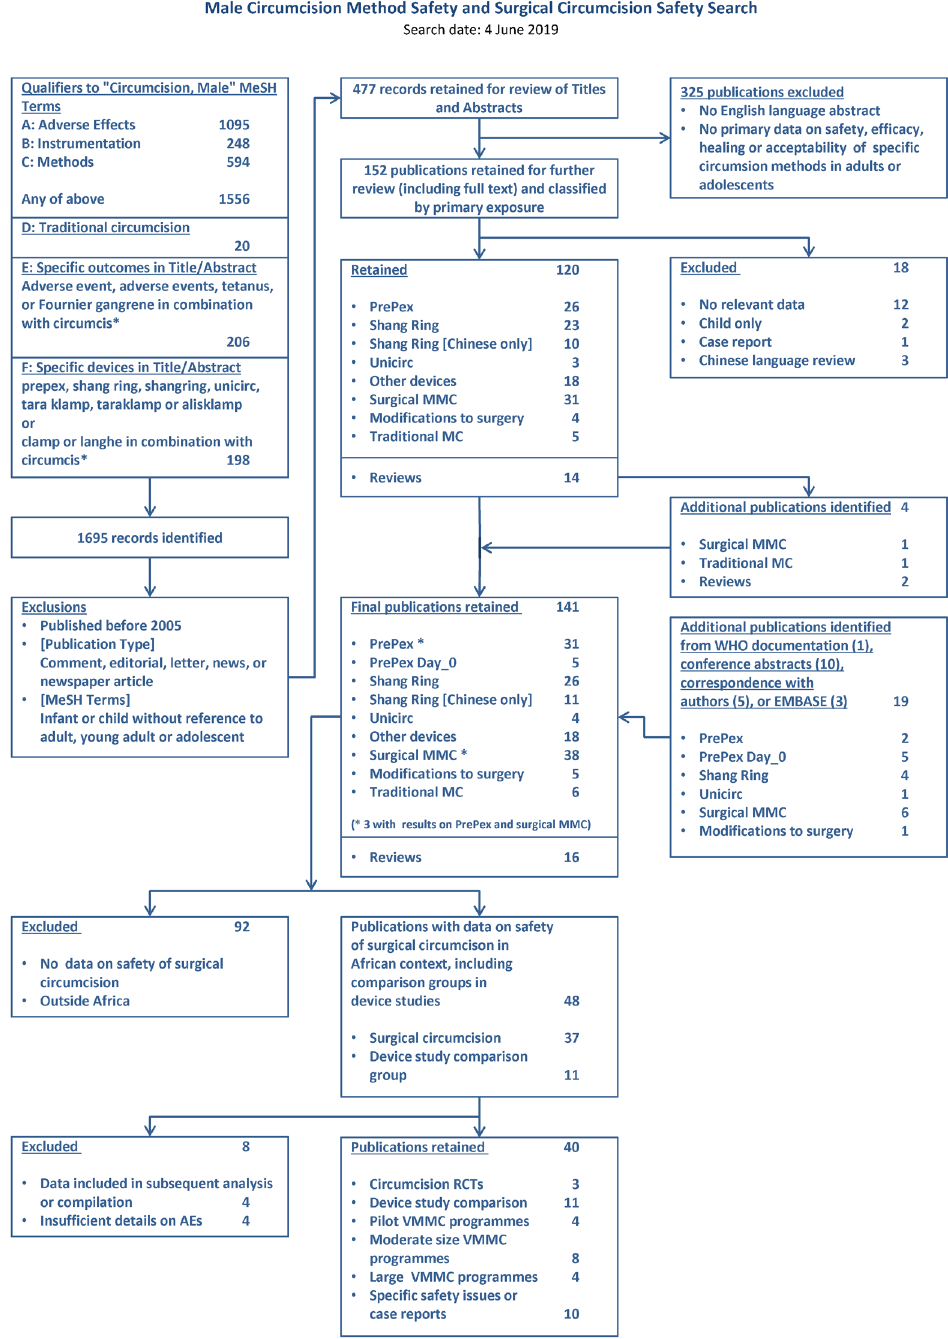
Figure 1. PRISMA